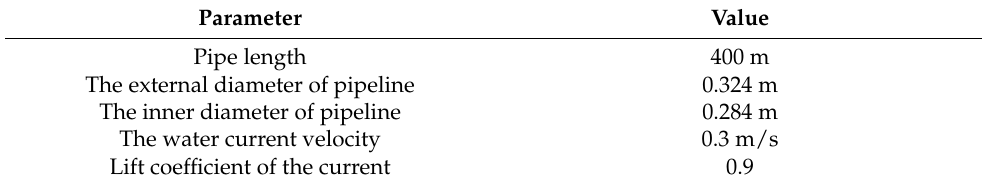
Figure 8. Comparison of the simulated and experimental voltage output with the loading resistance of ( a ) 1 M Ω and ( b ) 10 M Ω . Table 2. Parameters of the marine pipeline and ocean